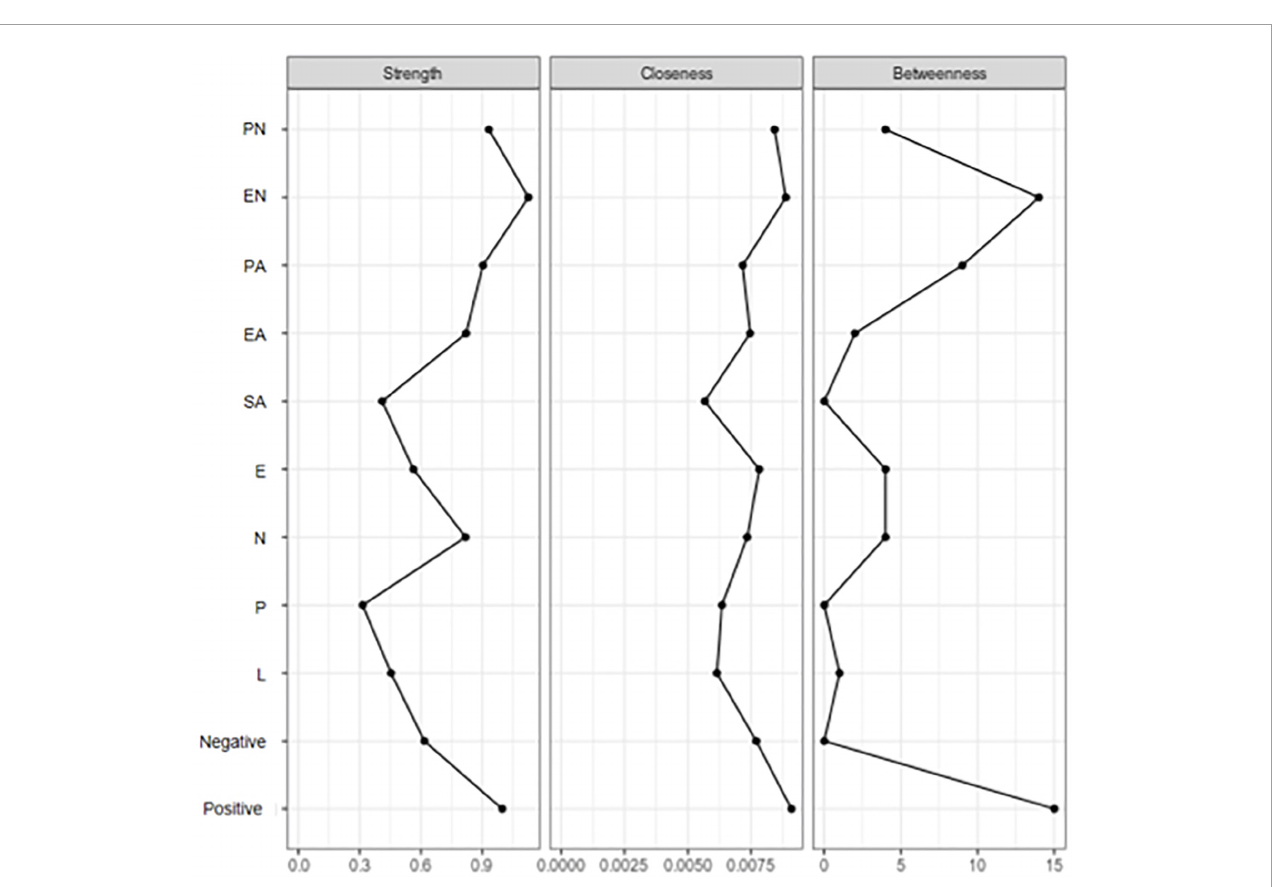
FIGURE2 Centrality measures among MOD group (EN, emotional neglect; EA, emotional abuse; PN, physical neglect; PA, physical abuse; SA, sex abuse; N, neuroticism; E, extraversion; P, psychoticism; L, lie scale; Positive, positive coping; Negative, negative coping).